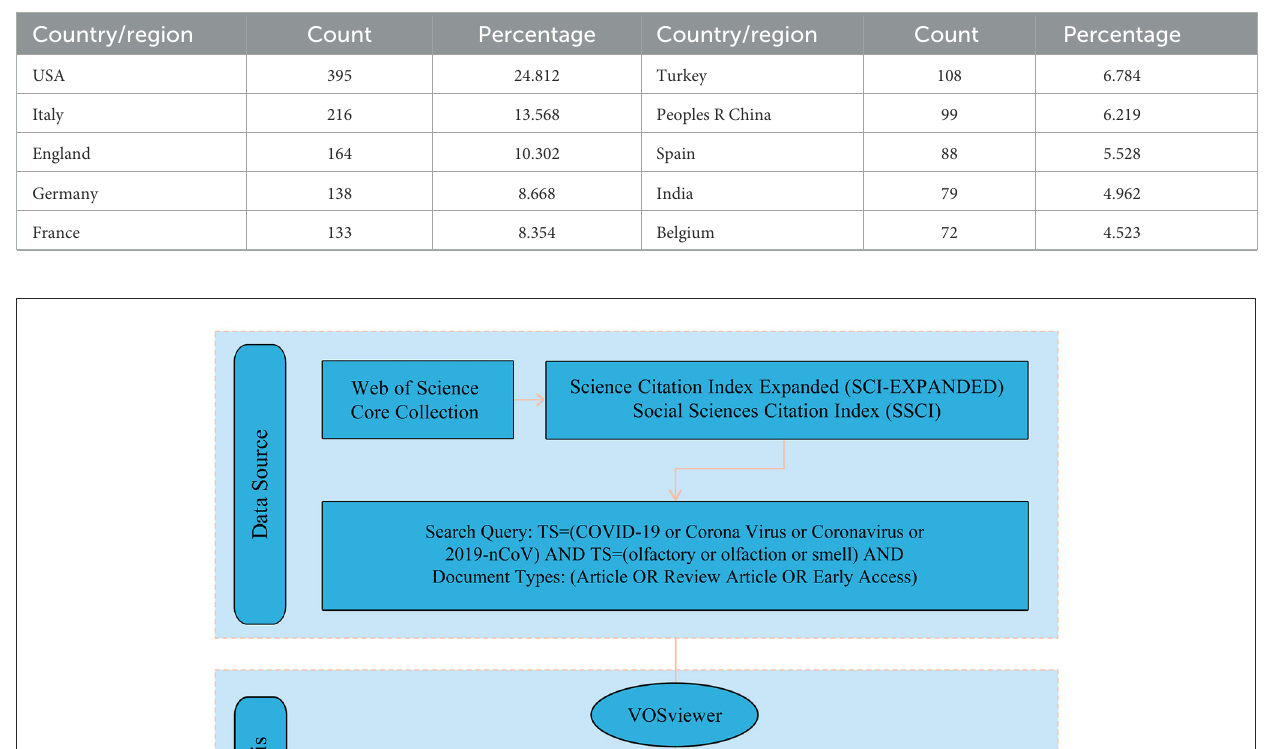
TABLE 2 The geographical distribution (Top 10).